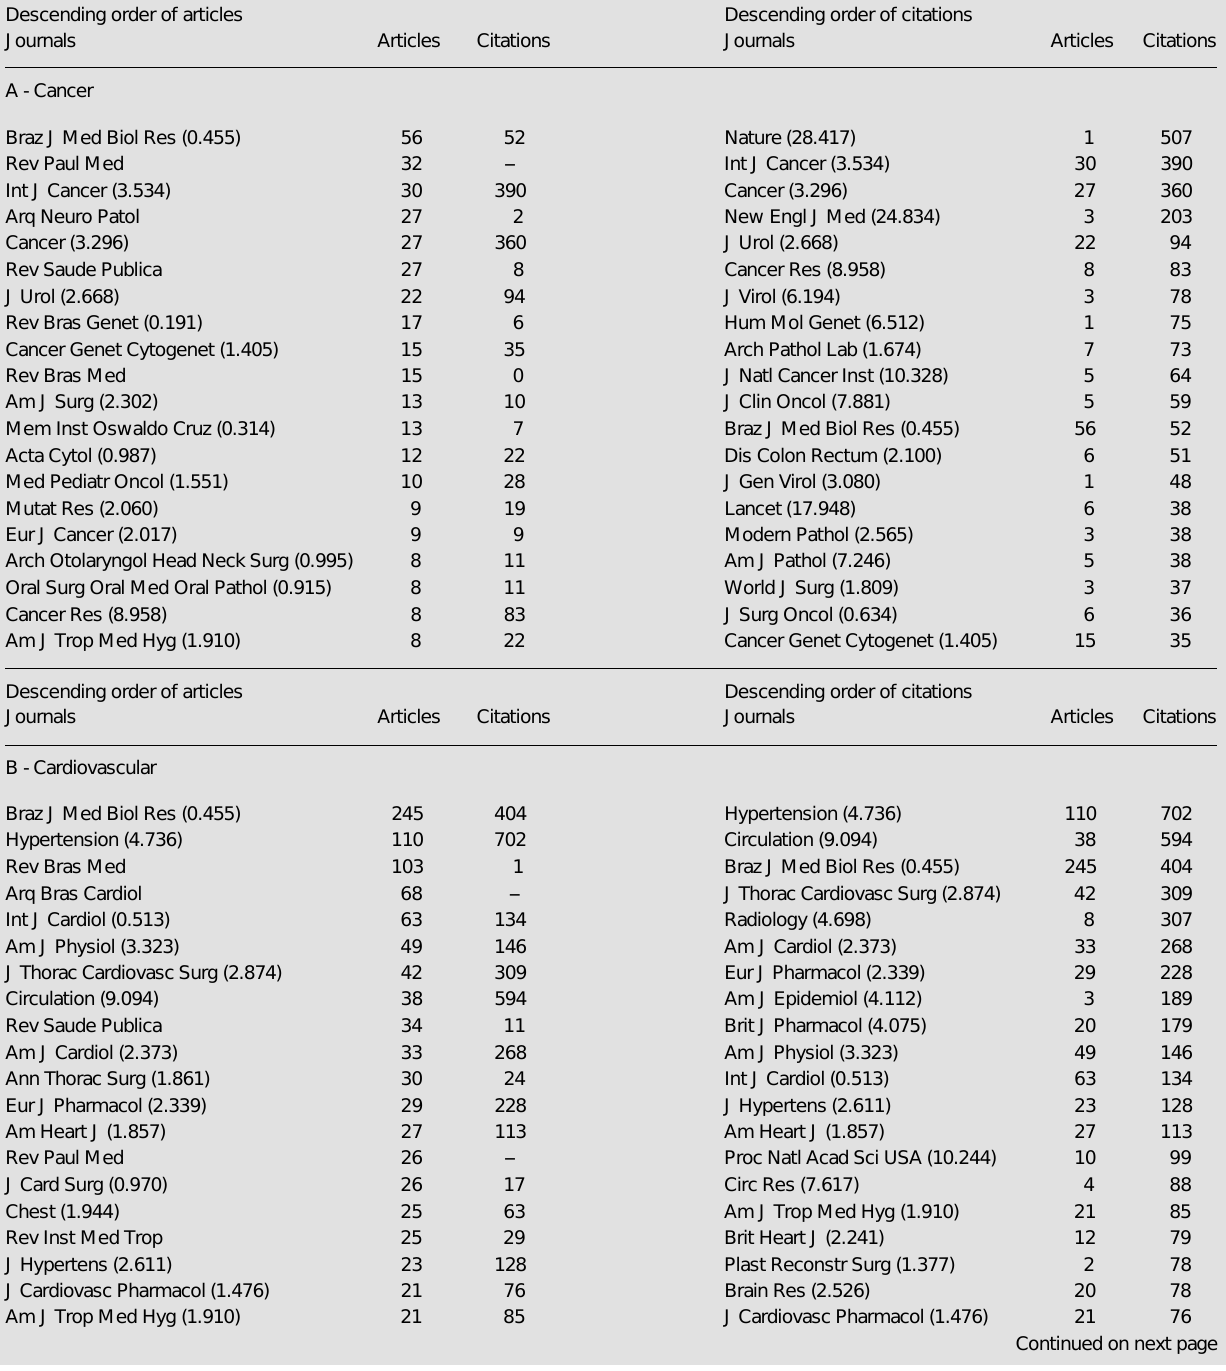
Table 5 - Ranking of the 20 journals that either published the highest number of articles or collected most citations during the 1981-1995 period. The ranking is established in descending order of number of articles and citations. Numbers in parenthesis are ISI’s impact factor for each Journal for 2 years. Some journals listed below are not indexed by ISI and had no citations or impact factor recorded in the ISI data